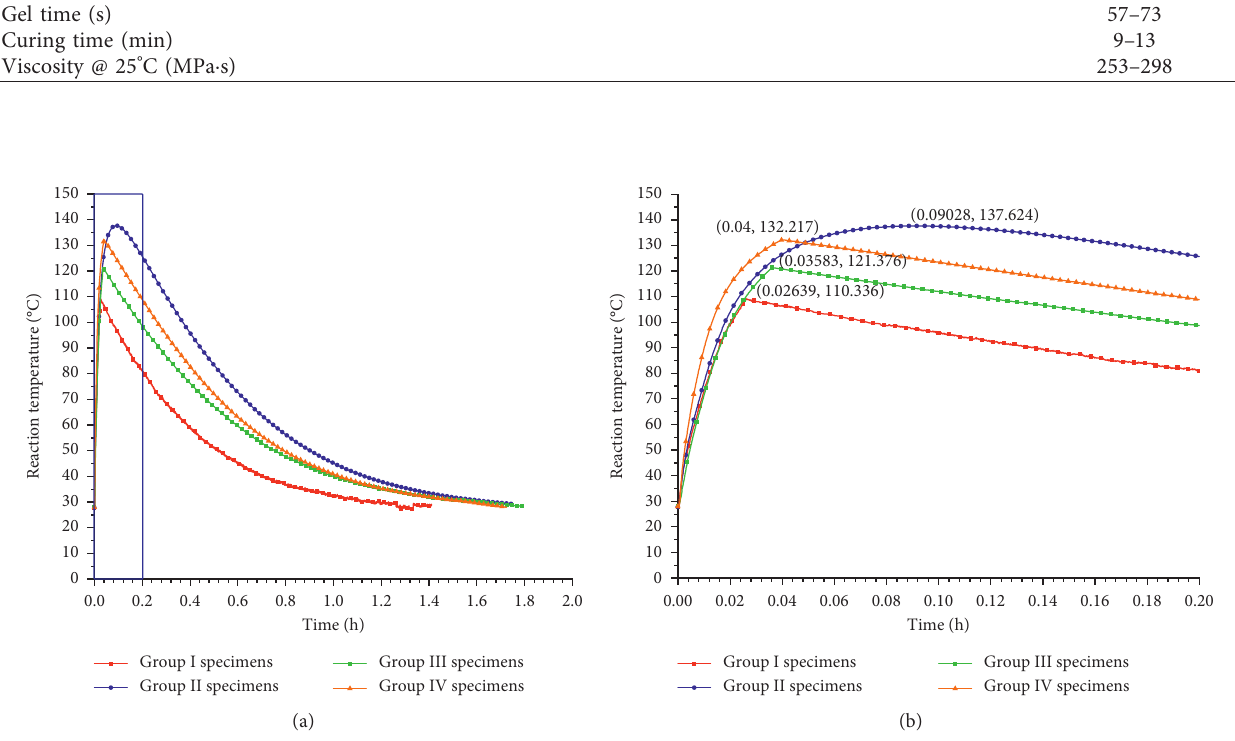
Figure 3: The relationship between reaction temperature and time: (a) overall curves of reaction temperature; among them, the mass ratio of polyether triols and polyether tetraols of group I to group IV was 9:11, 10:10, 11: 9, and 8:12, respectively; (b) magnified curves of reaction